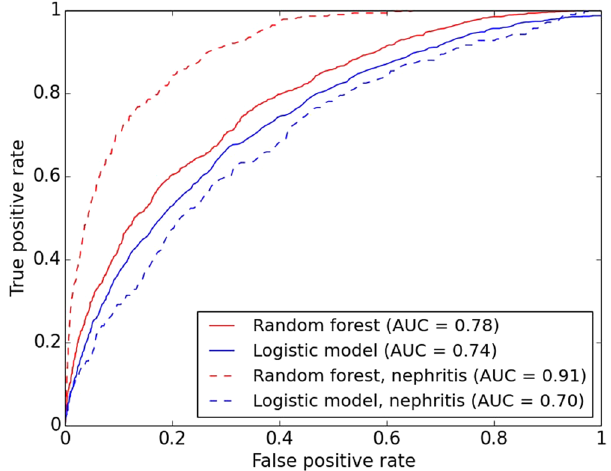
Figure 1. Prediction accuracy. Prediction accuracy measured by the area under the curve (AUC) using genotype data from the Immunochip. All data from 1,160 SLE patients and 2,711 controls were used for the prediction of SLE disease status by random forests (RF) and using a risk score based on the single SNP association analysis. The random forest classification was also applied to the subgroup of the SLE patients diagnosed with lupus nephritis (n = 274) together with all control